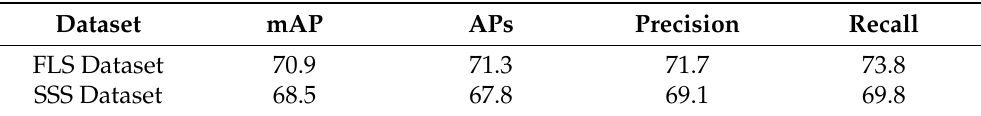
Table 6. Test results of DP-ViT on Sonar Images with Few Samples (FLS Dataset: Forward-Look Sonar Dataset, SSS Dataset: Side-Scan Sonar Dataset).